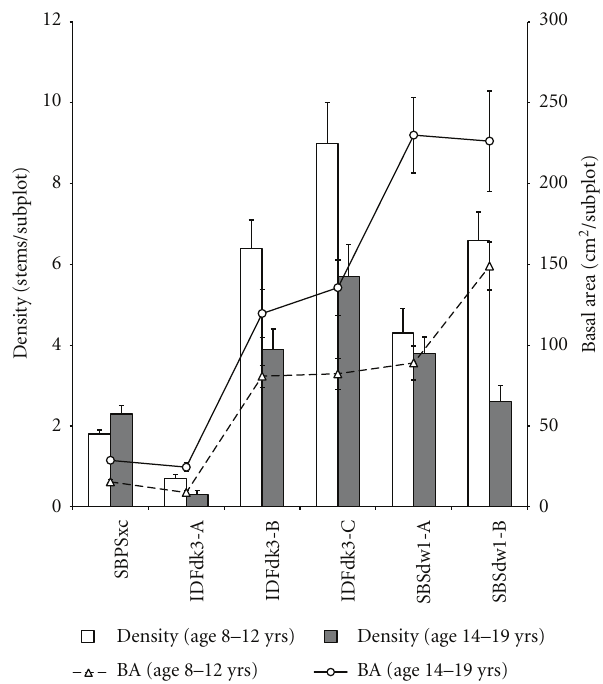
Figure 4: Average principal competitor density and basal area per 10m 2 subplot at individual sites at age 8–12 and age 14–19. Error bars are one standard error.